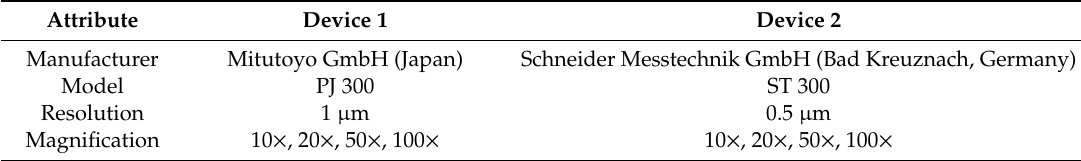
Table 1. Technical specifications of the optical profile projectors used to characterize the drill geometry.